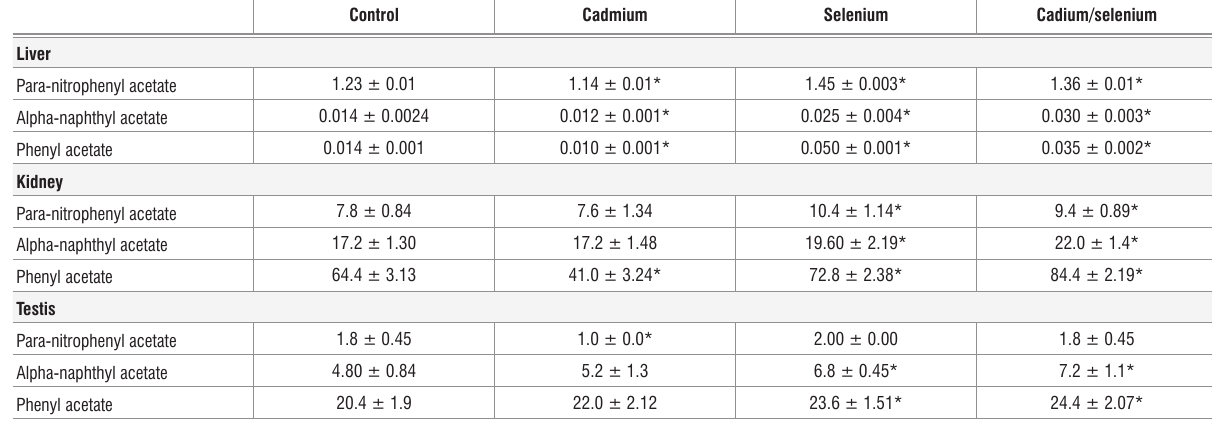
*Statistically significantly different from control at